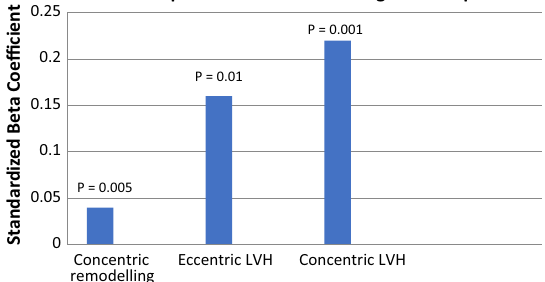
Fig. 8 Regression analysis to show the relative importance of